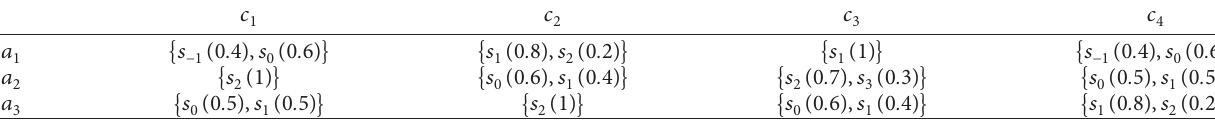
Table 2: The PLDM R ( 2 ) provided by the online media e